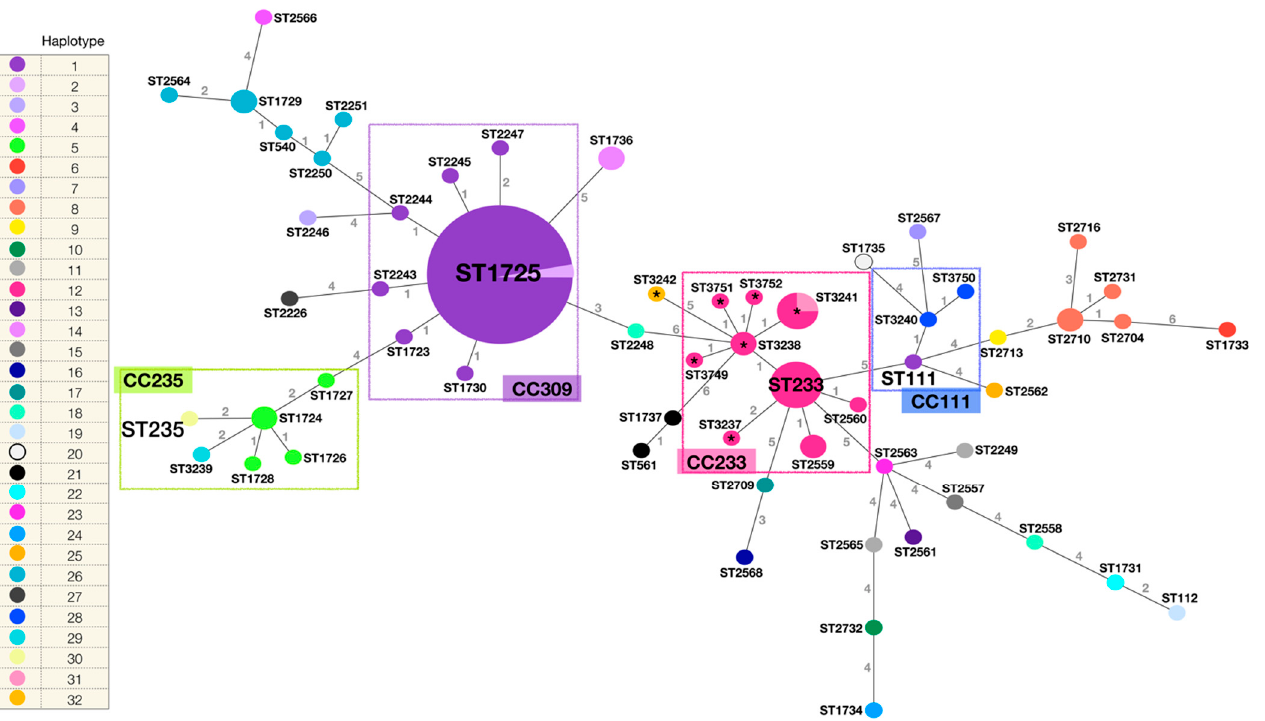
Figure 3. Phylogenetic network of the P. aeruginosa STs identified in the HIMFG. STs are indicated. The size of the circumferences is given by the ST frequency, and the numbers in the lines indicate the differences in the allelic profile between the strains ( n = 7 genes, maximum number of differ- ences). The colour of the ST is given by the identified haplotype ( mexR, nalC, nalD ). Total number of haplotypes = 32. Total number of STs = 59. Total number of strains = 106. Relevant clonal complexes (CC) are highlighted with rectangles (CC235, CC309, CC233, and CC111). Strains related to the out- break are highlighted with *.